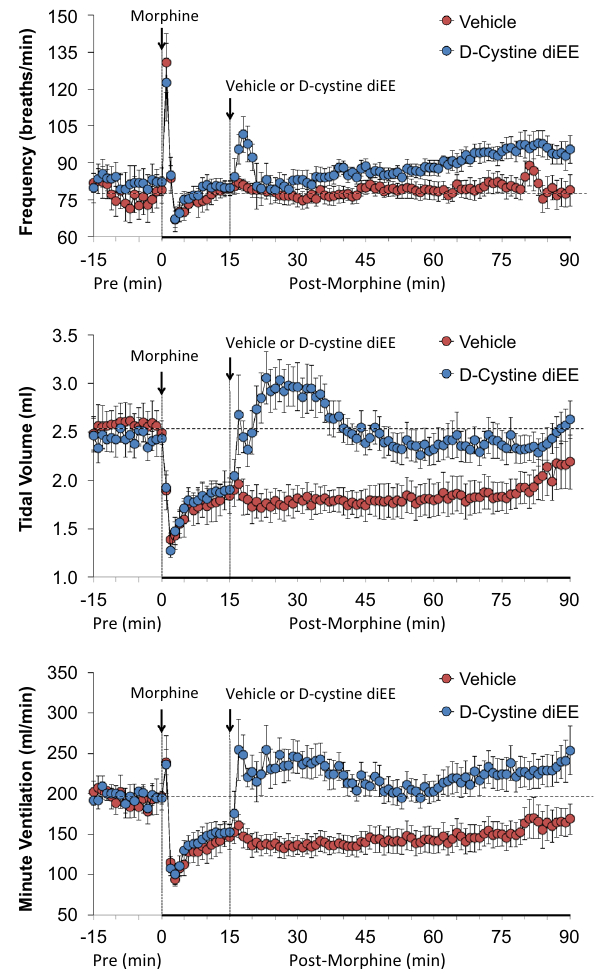
Figure 1. Changes in frequency of breathing (top panel), tidal volume (middle panel) and minute ventilation (bottom panel) in freely moving rats upon (a) injection of morphine (10 mg/kg, IV) and subsequent injection of vehicle (saline) or d-cystine diethyl ester (d-cystine diEE, 500 μmol/kg, IV). The data are presented as mean ± SEM. There were 9 rats in each